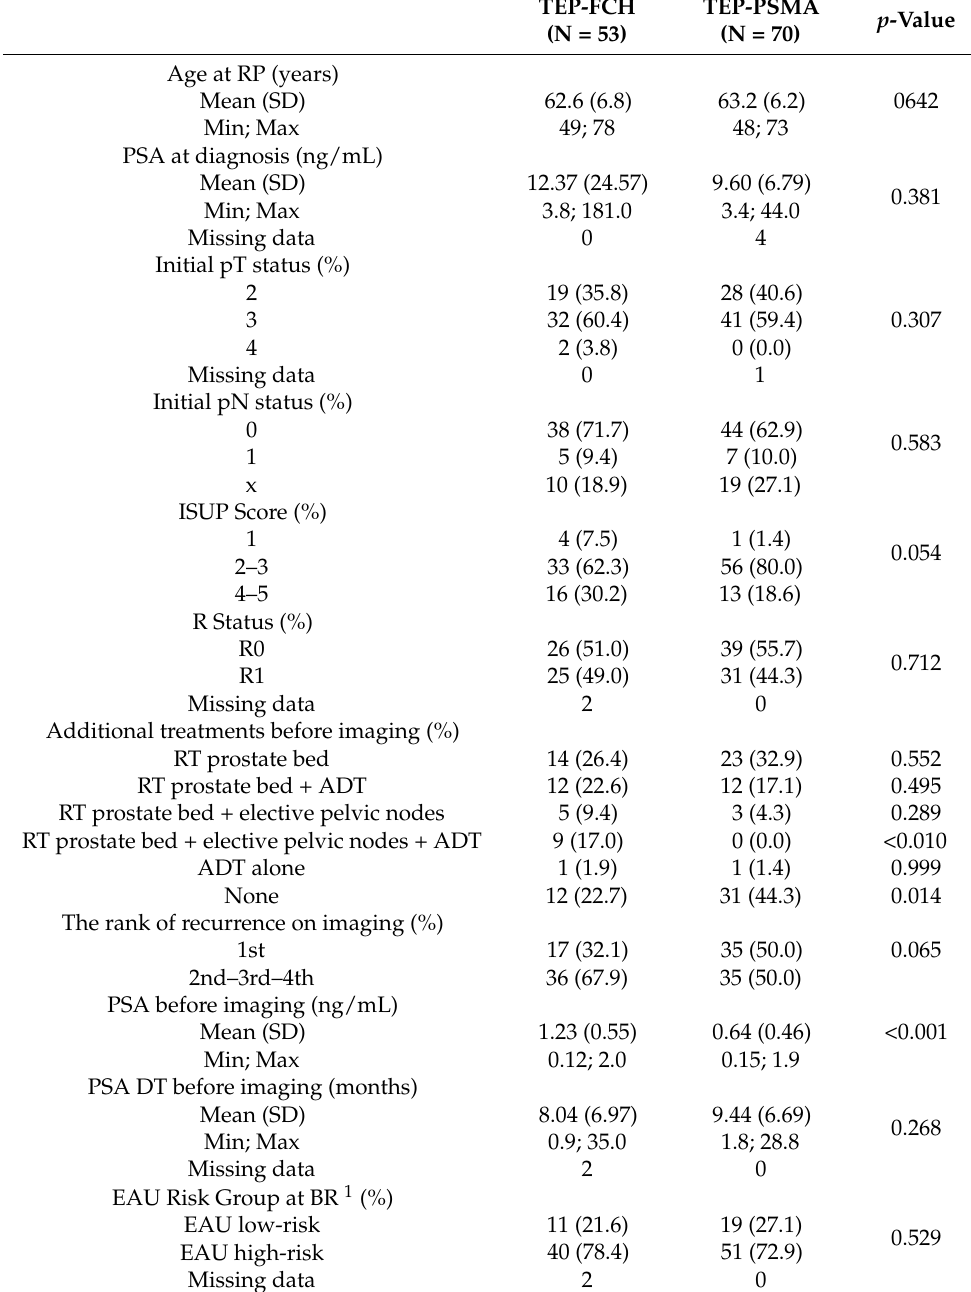
Table 1. Patient